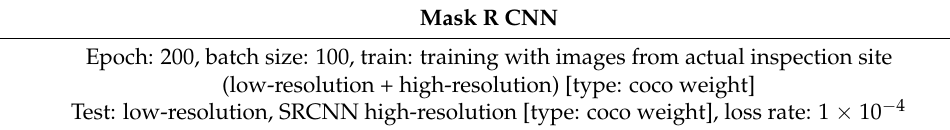
Table 4. Mask R-CNN parameter Table 3. BRISQUE measuring result: real bridge image.